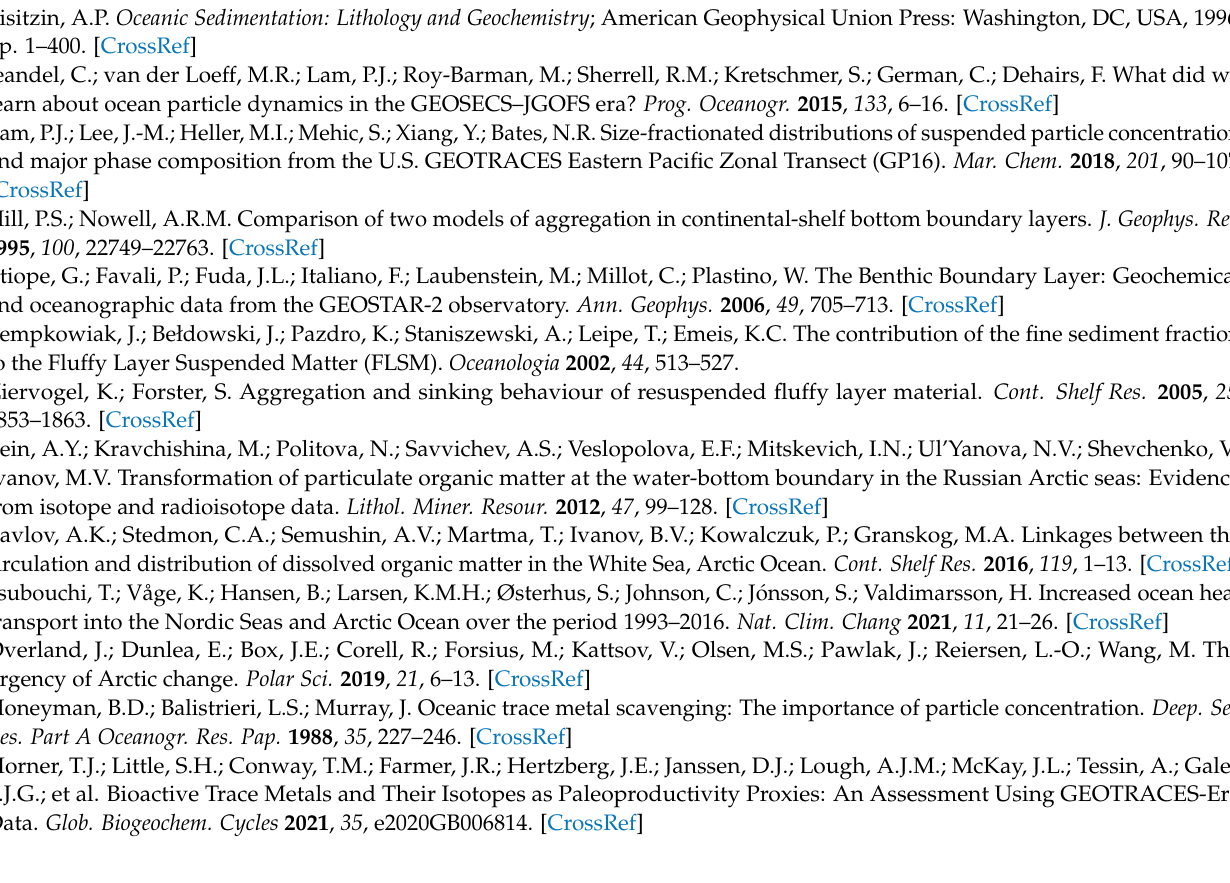
Table S3: Elemental composition of fluffy layer suspended